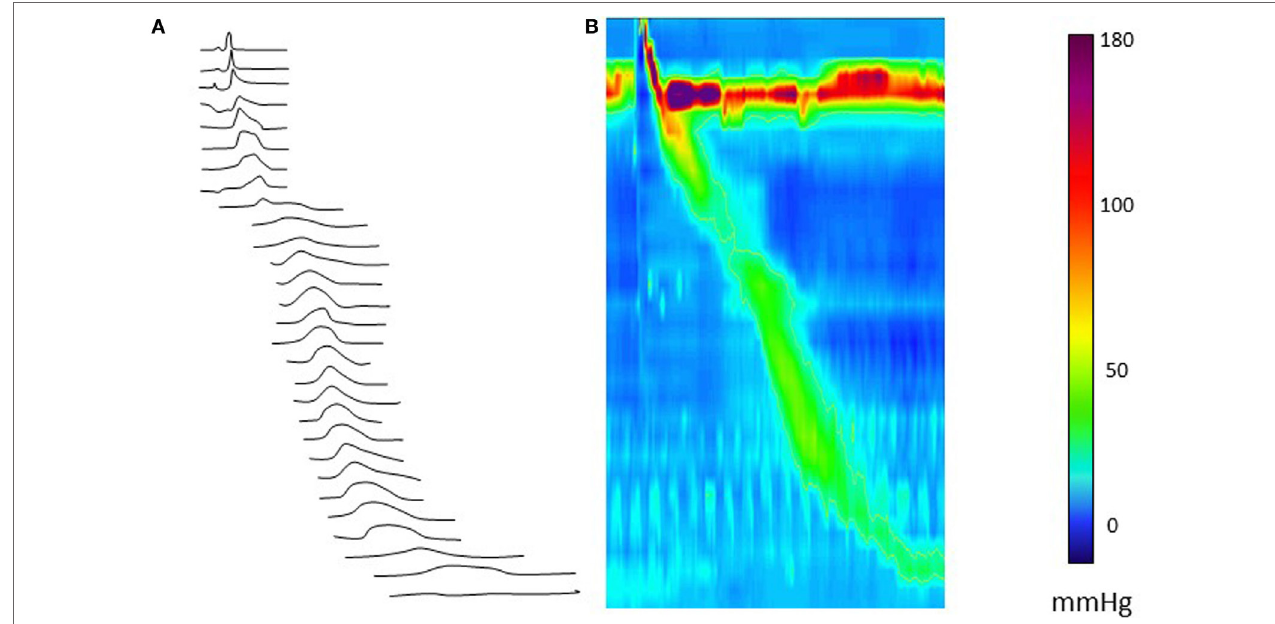
FigURe 1 | Esophageal high-resolution manometry tracing of a normal liquid swallow, presented as a line plot (A) and as a color (Clouse) plot line plot (B) . The color panel shows the corresponding pressure values.